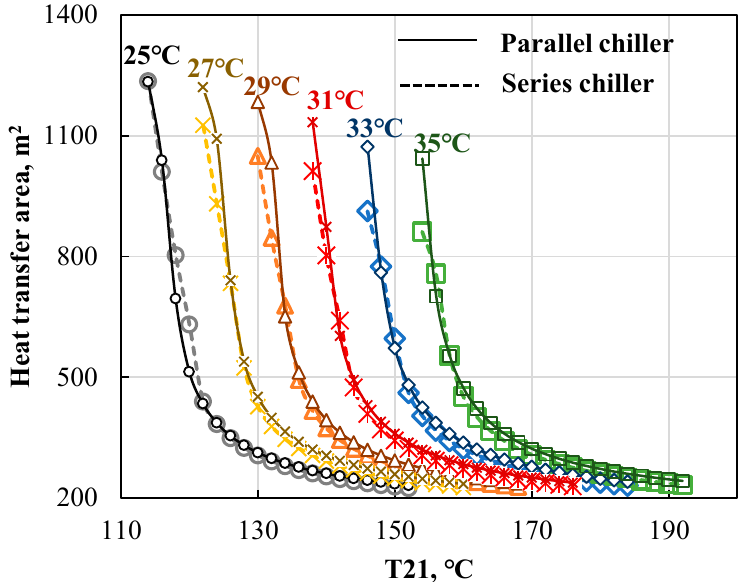
Figure 3. Variations of heat-transfer areas with two types of absorption chillers as functions of cooling temperature and steam temperature (T21).